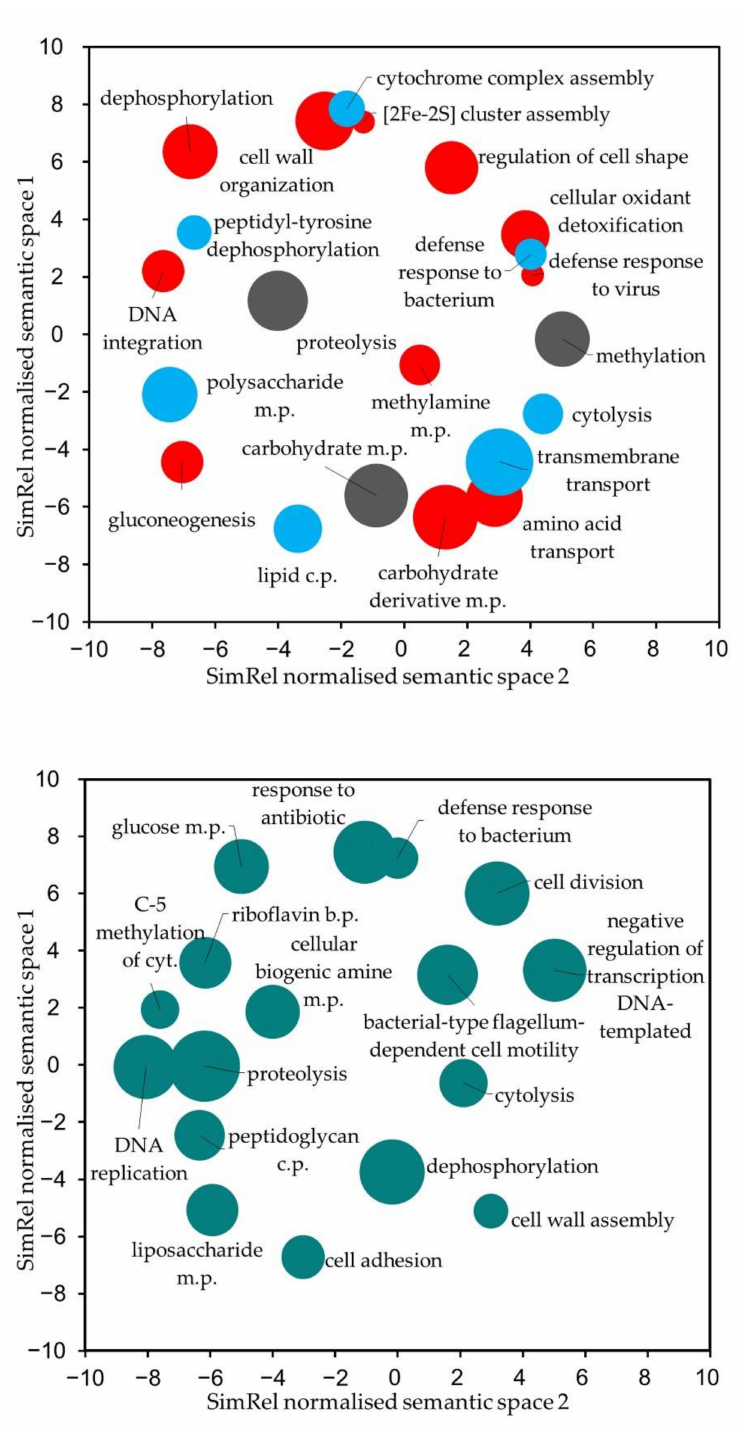
Figure 4. GO term semantic relationship-based visualization of distinct functional features of B. toy- onensis isolates Nt.18 and Nt.37 identified by protein sequence-based genome comparative analysis. GO terms of singleton features ( A ) and a set of low-amino-acid-identity proteins (<90%) of core features ( B ) were summarized using the ReviGO algorithm. Bubble size indicates the log value of the frequency of the GO term in the GO annotation database (bubbles of more general terms are larger). The red, blue and gray colors of the bubbles correspond to GO terms that were unique to isolates Nt.18 and Nt.37 or common to both isolates, respectively. Abbreviations: c.p.—catabolic